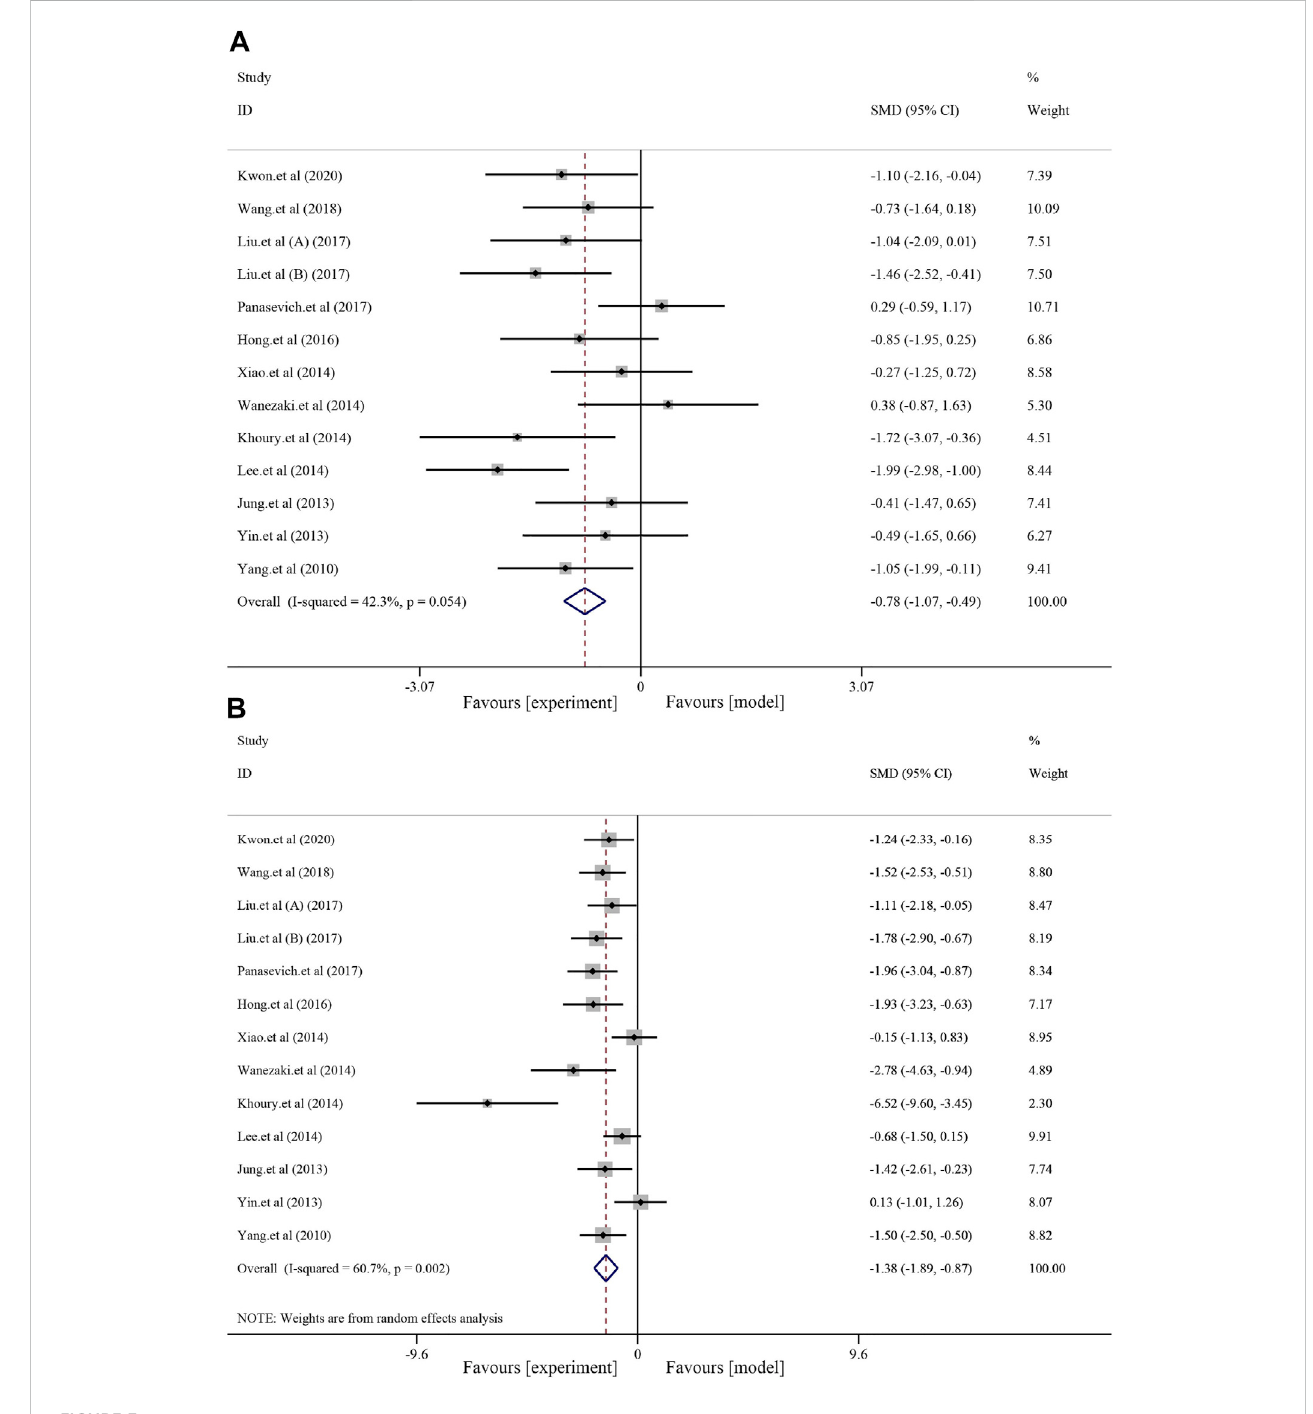
FIGURE 3 Effects of soybean on TG and TC levels in preclinical studies. (A) Pooled effect of TG. (B) Pooled effect of